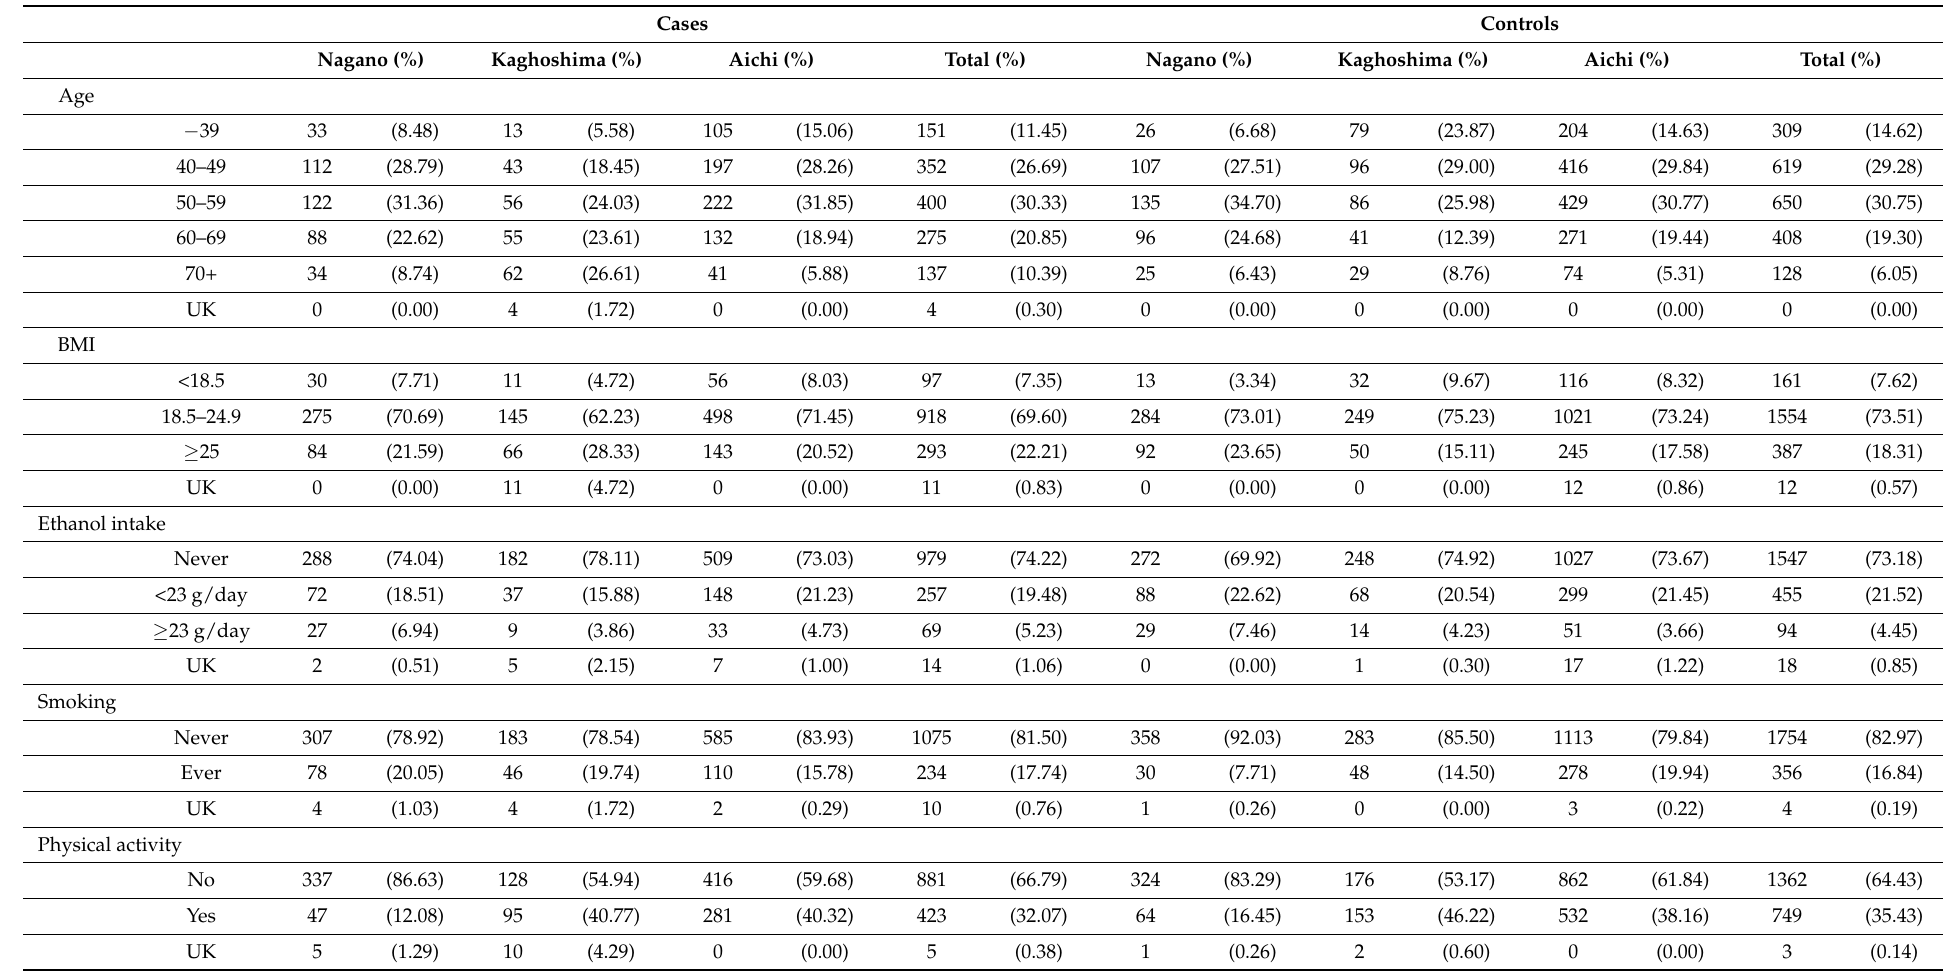
Table 1. Characteristics of study